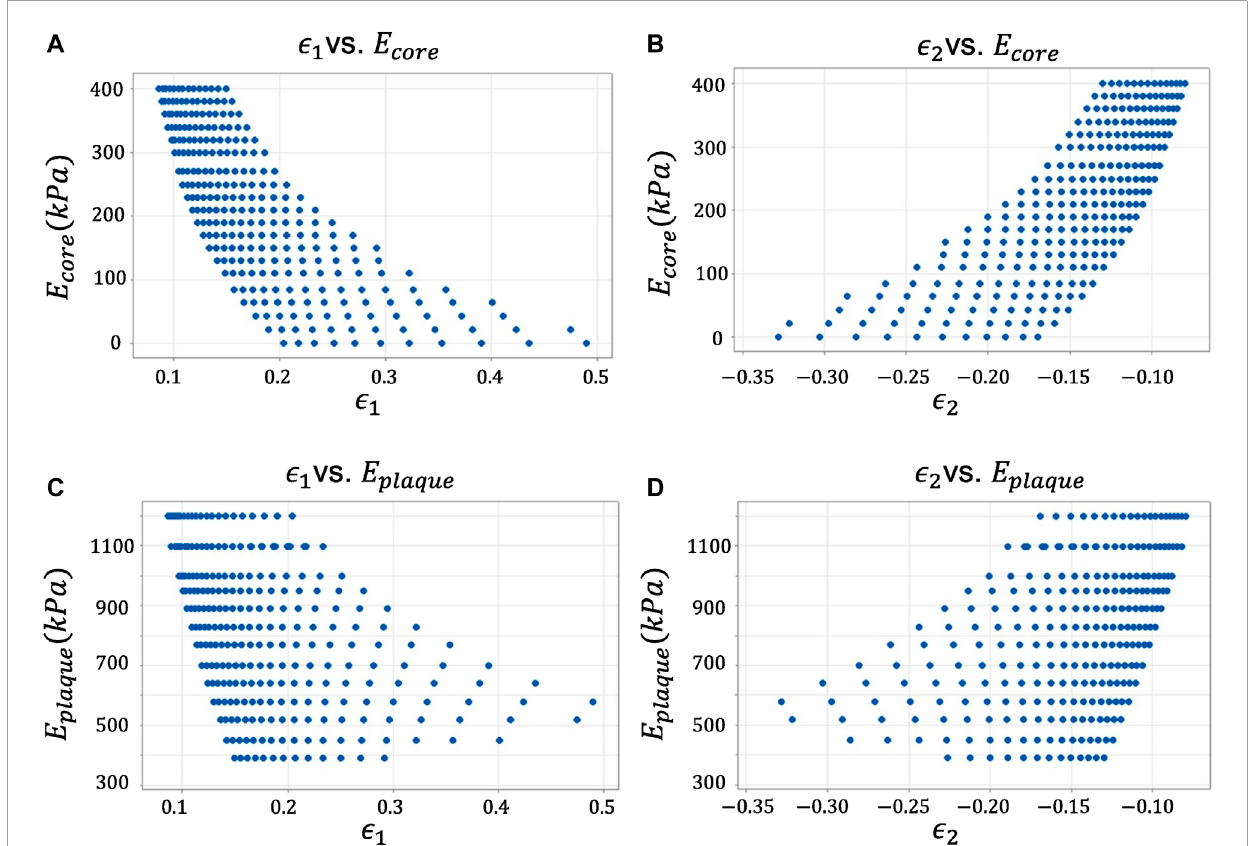
FIGURE 4 Descriptive statistical analysis of the candidate variables against the response variables. (A) Maximum Principal Strain ϵ 1 vs. Young’s modulus of the lipid core E core . (B) Minimum Principal Strain ϵ 2 vs. Young’s modulus of the lipid core E core . (C) Maximum Principal Strain ϵ 1 vs. Young’s modulus of the lipid core E plaque . (D) Minimum Principal Strain ϵ 2 vs. Young’s modulus of the lipid core E plaque